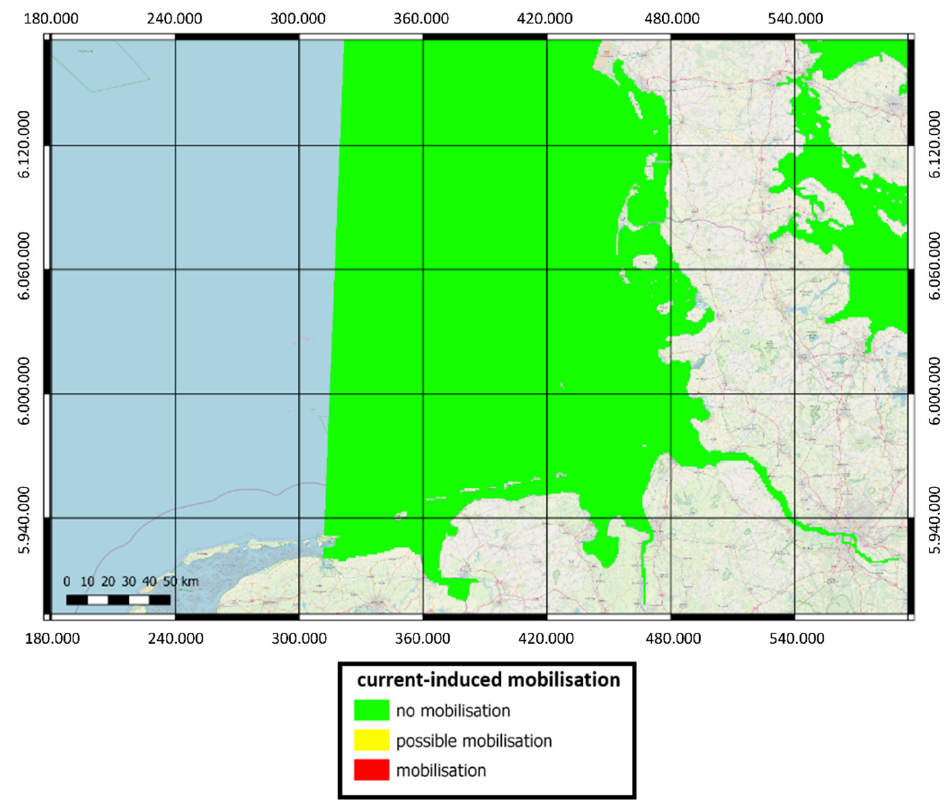
Figure 10. Regions of current-induced mobilization for the British 250-pound general purpose bomb